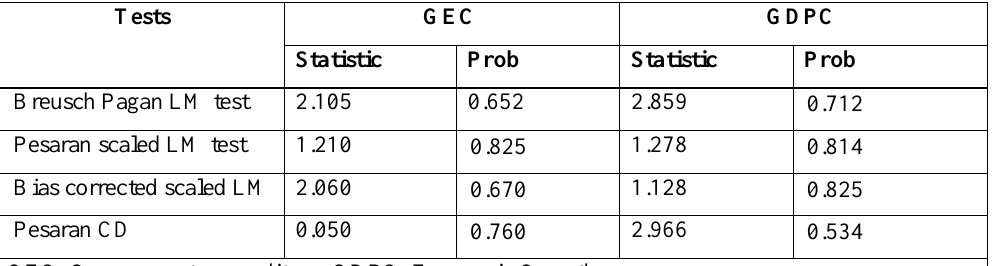
Table 2. Cross-sectional Independence Test